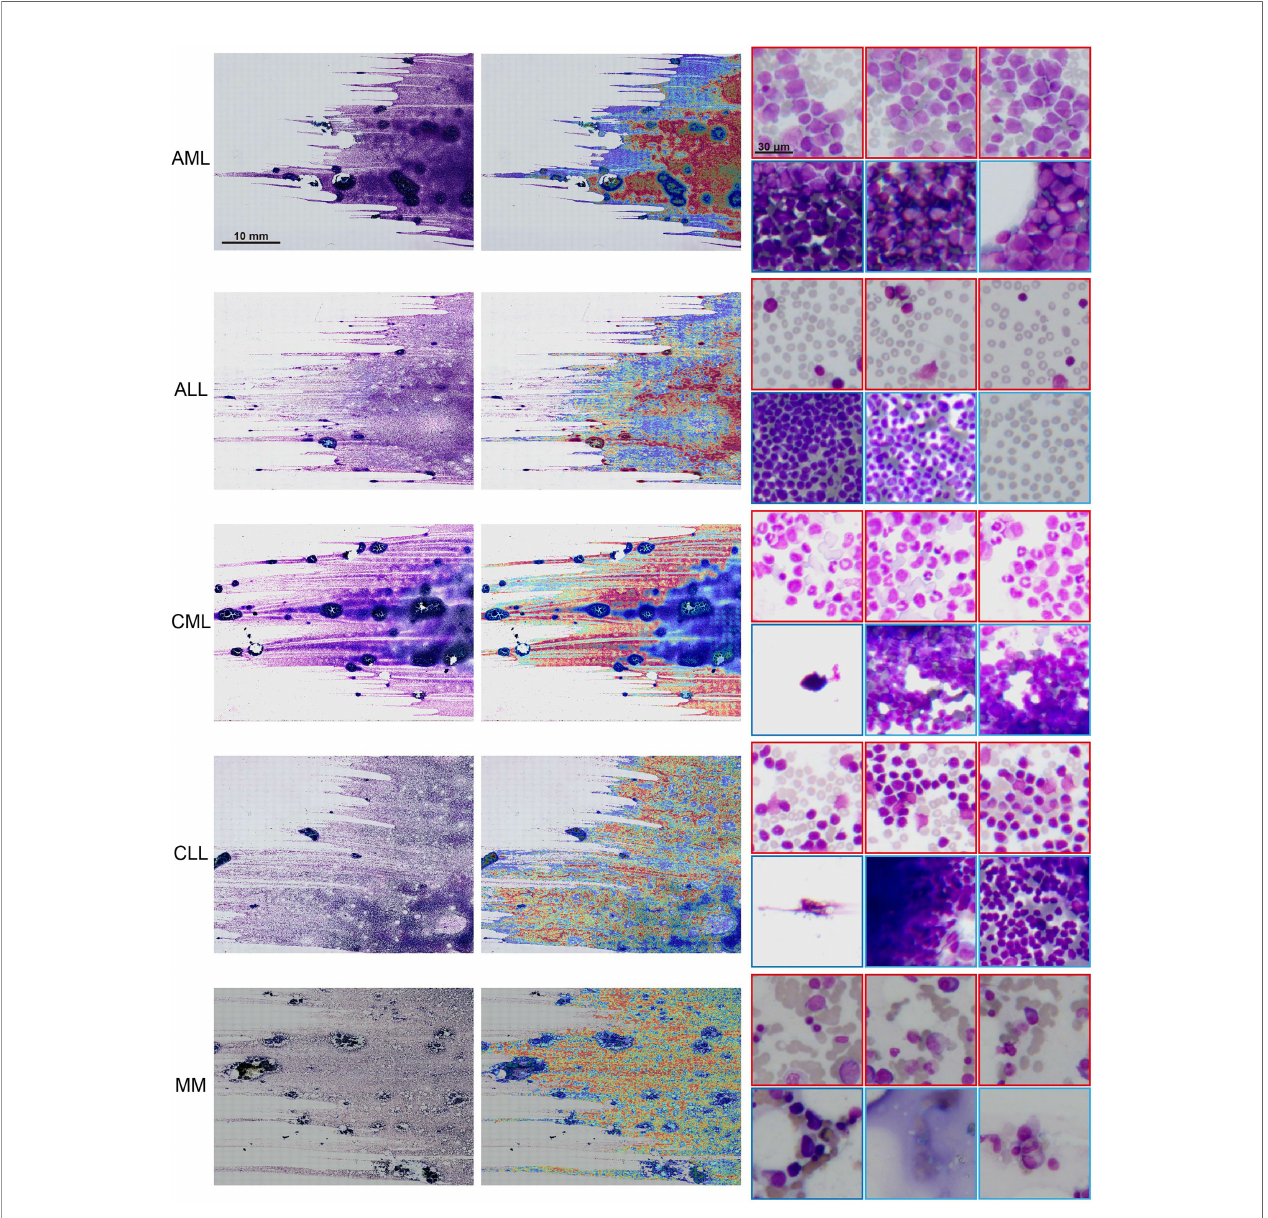
FIGURE 4 | Interpretability and visualization at 10× magni fi cation. Raw WSIs of representative slides of different kinds of malignant blood tumors (left), the generated attention heatmap (middle). The region of strongest attention (red border) usually focuses on the region of interest (ROI) with distributed blast cell tracks, whereas the region of low attention (blue border) includes images with dense cell distribution, no cells, and other kinds of cells